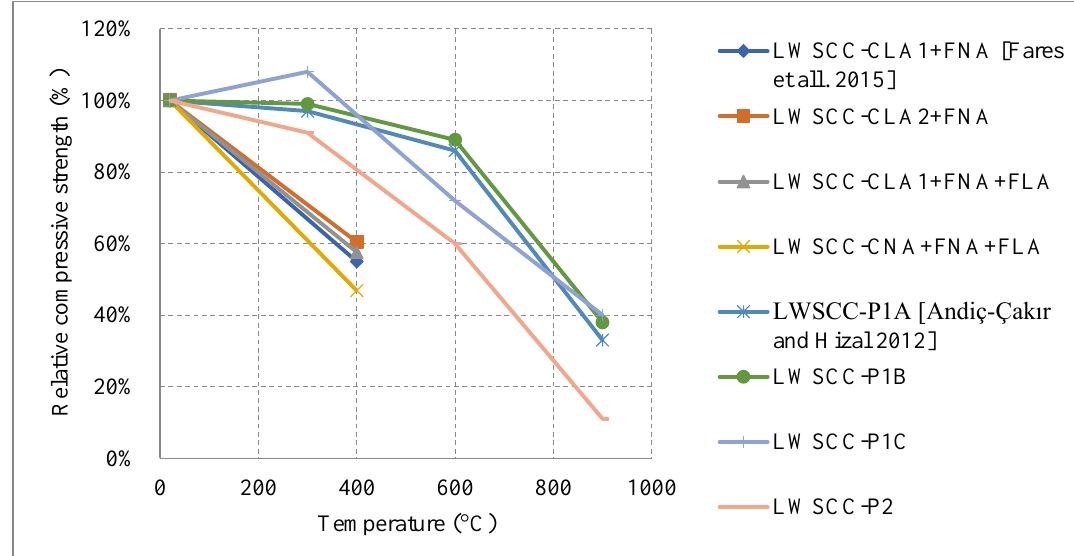
Figure 33. Relative compressive strength of naturally cooled LWSCC with different constituents. CLA = coarse lightweight aggregate; CLA2 has smaller average particle size than CLA1; CNA = coarse normal-weight aggregate; FLA = fine lightweight aggregate; FNA = fine normal-weight aggregate; P1A = mixture having a 0.42 w/p ratio; P1B; mixture having a 0.38 w/p ratio; P1C = mixture having a 0.35 w/p ratio; P2 = mixture having a 0.34 w/p and different proportions of materials [101,102].